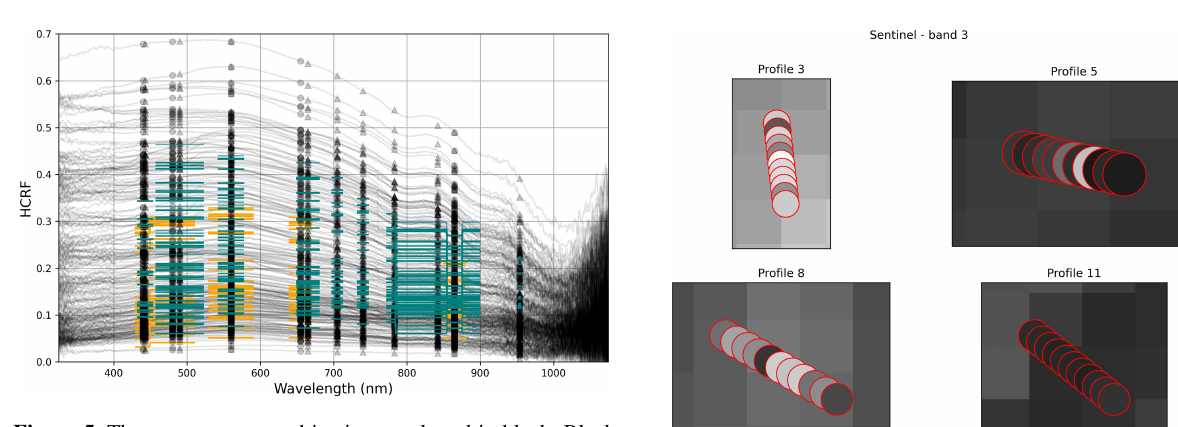
Figure 5. The spectra measured in situ are plotted in black. Black circles indicate the central wavelengths of the Landsat bands; black triangles indicate those of the Sentinel bands (see Table 3). Orange and teal lines represent the wavelength range of the respective Land- sat and Sentinel bands along the horizontal axis and the satellite- derived reflectance at the sampling points of each spectrum on the vertical axis.